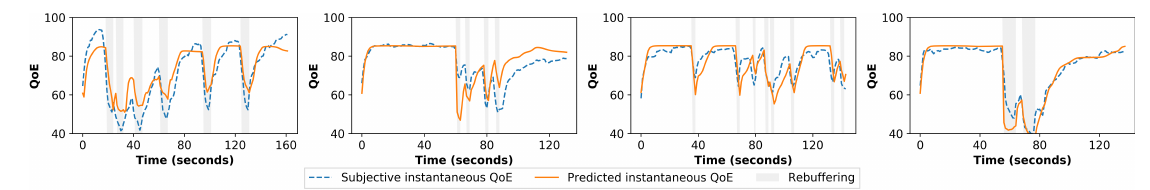
Figure 7. Some examples of instantaneous QoE prediction performance obtained from the LSTM-QoE model on different test videos of the database.